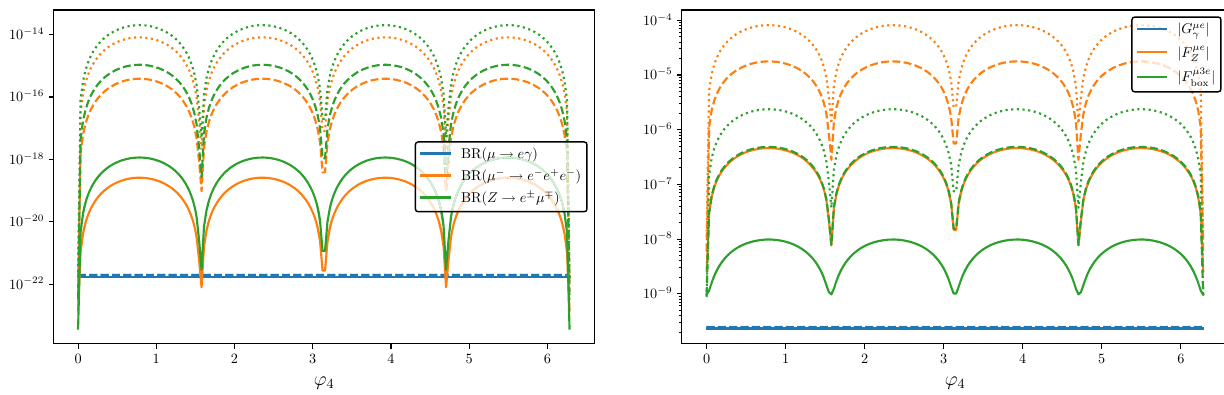
Fig. 6 Dependence of cLFV observables (left) and several contributing form factors contributing to the decay rates (right) on the Majorana CPV phase ϕ 4 , for non-vanishing Dirac CPV phase, δ 14 = π . We again present on the left BR( μ → e γ ) (blue), BR( μ → 3 e ) (orange) and BR( Z → e μ ) μ e μ e | (orange) and | F μ 3 e | (green). We consider fixed values of the mass of heavy sterile states: (green), while on the right one finds | G γ | (blue), | F Z box solid, dashed and dotted lines respectively correspond to m 4 = m 5 = 1 , 5 , 10 TeV